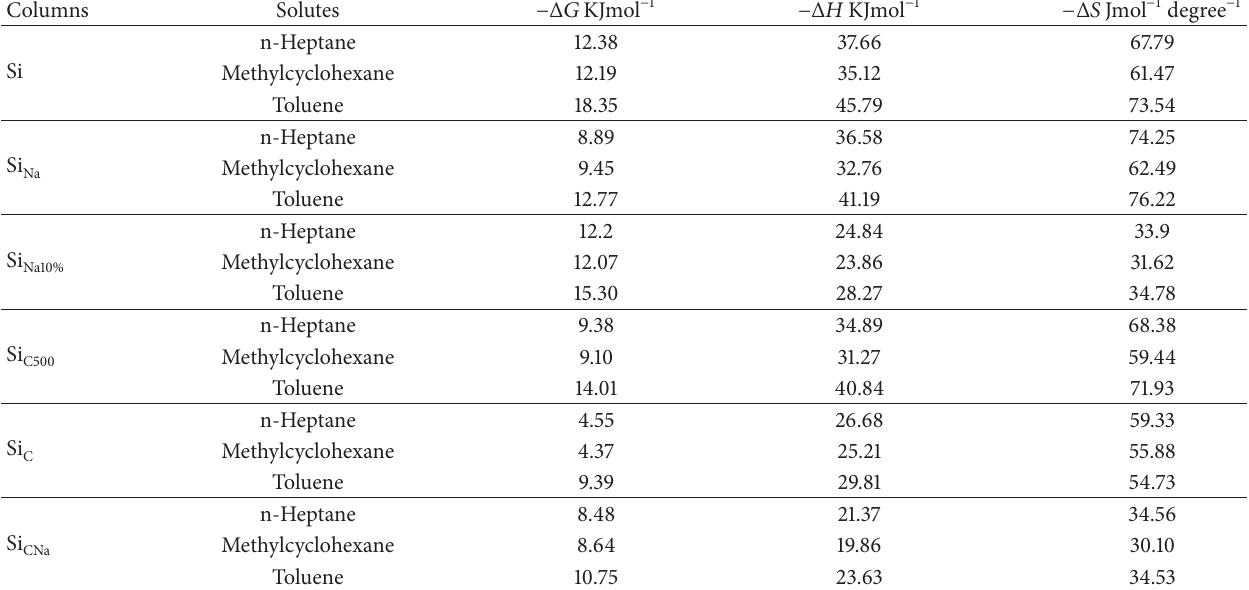
Table 3: Thermodynamic parameters of parent and modified silica stationary